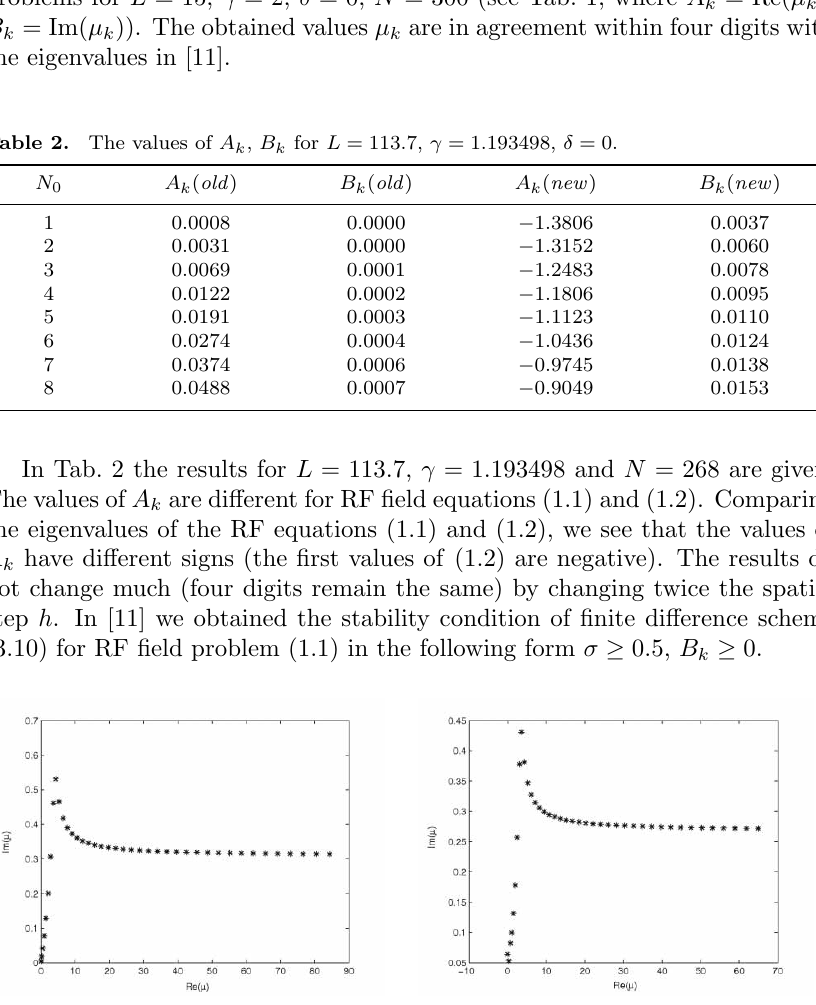
Figure 4. First 40 discrete (old) eigenvalues in the plane (Re μ, Im μ ), N = 300, L = 15, γ = 2, δ = 0, I = 0.